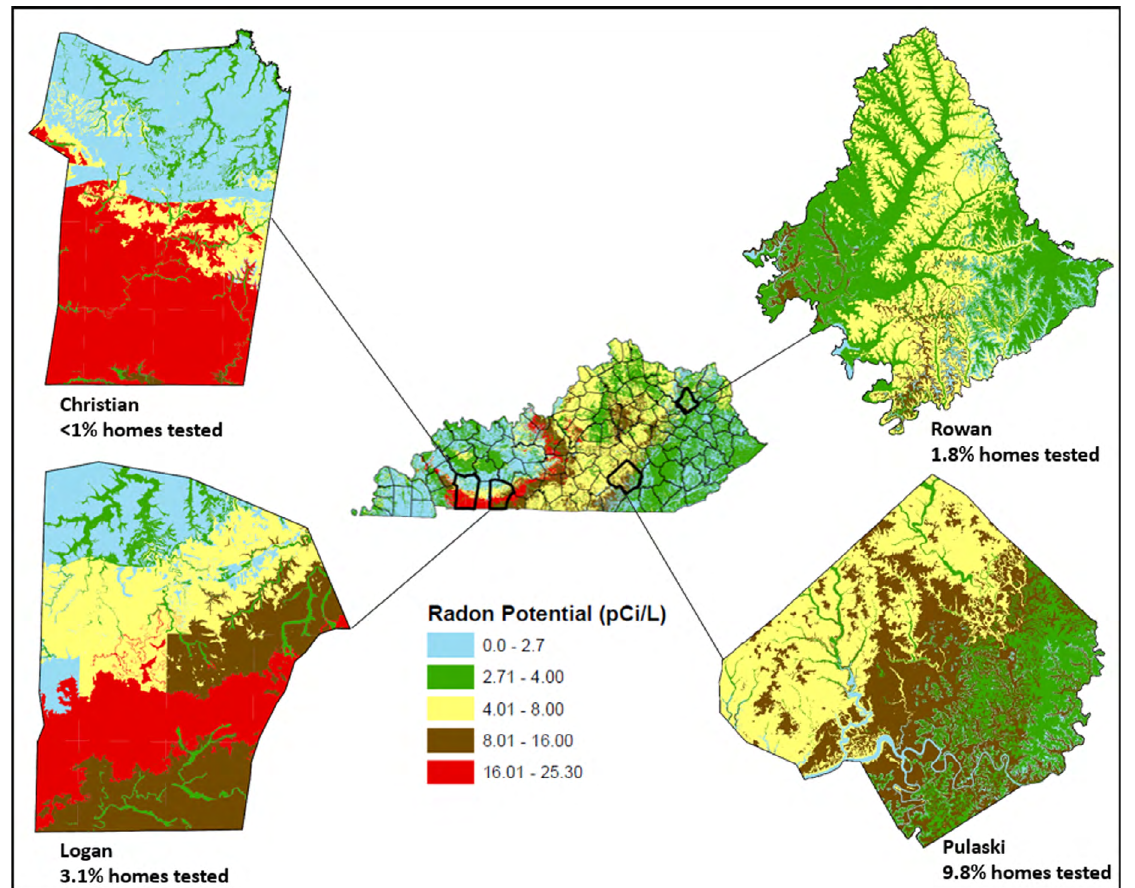
Figure 1 Radon risk potential by study